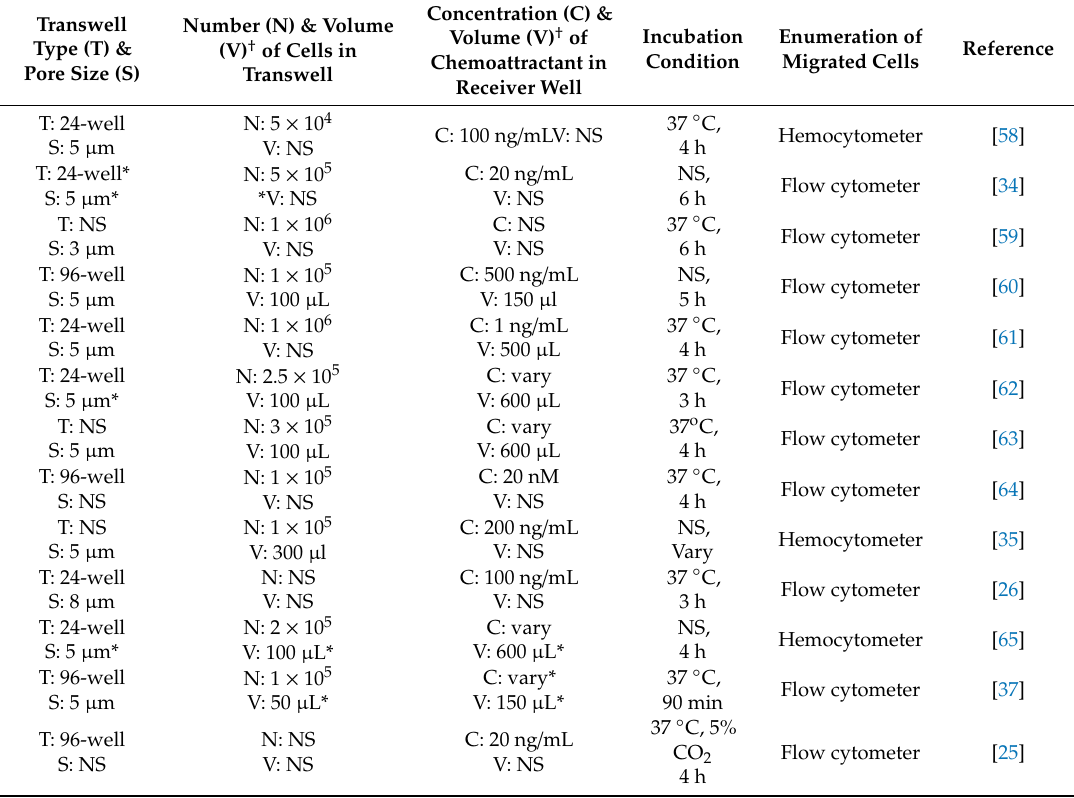
Table 1. Tregs migration assay